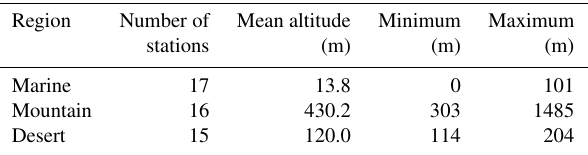
Table 3. Number and altitude statistics for the regions – marine, desert, and